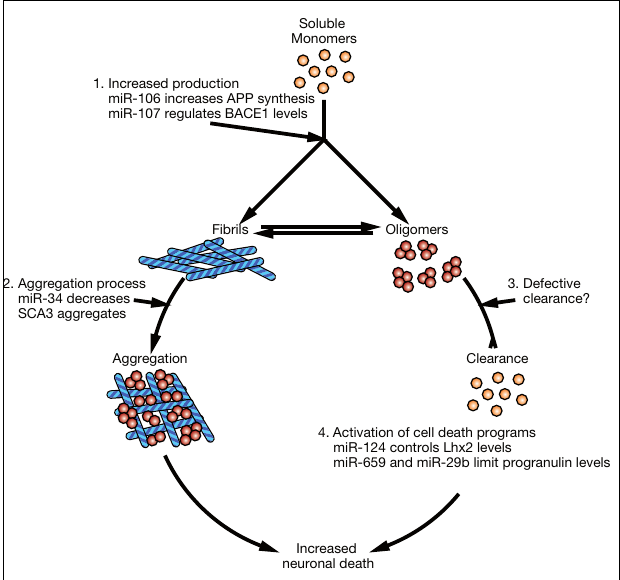
FIGURE 2 | Potential mechanisms of neurodegeneration induced by altered miRNA networks. Schematic representation of cellular pathways that could be affected downstream of miRNAs. (1) Defects in miRNAs could increase the levels of aggregation-prone proteins either directly (i.e., miR-106a and APP in AD) or indirectly (i.e., miR-107 acting through BACE1 or miR-137 acting through serine palmitoyltransferase in AD). (2) miRNAs could control the expression of proteins involved in proper folding or quality control, increasing the risk of protein aggregation. (3) miRNAs could impair the removal of aggregated proteins and therefore increase their levels and toxicity. (4) Finally, altered miRNAs might result in neuronal cell death due to increased levels of certain transcription factors (i.e., miR-124 controls neuronal survival by limiting the expression of Lhx2) or the imbalance between pro-survival and pro-apoptotic signals (i.e., in FTD, polymorphism rs5848 results in more efficient binding of miR-659 and decreased levels of the pro-survival factor progranulin).